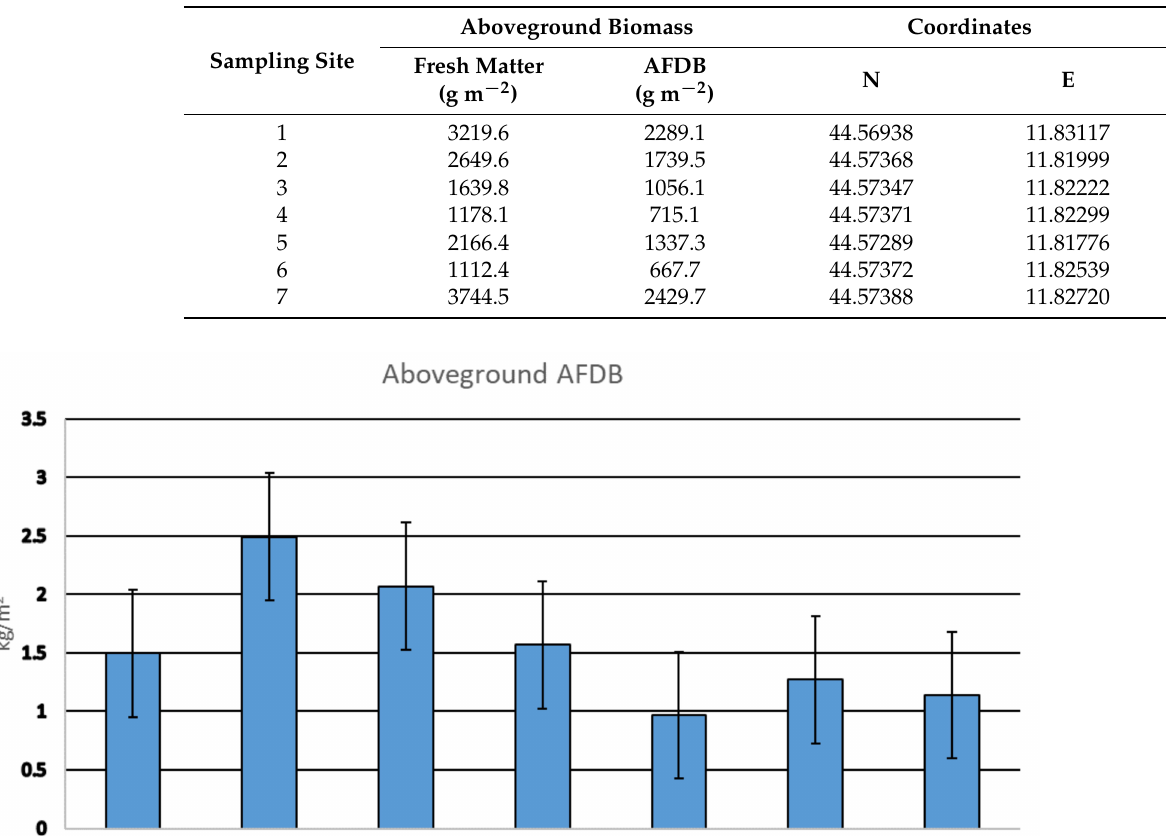
Table 3. Aboveground biomass, expressed as fresh matter and Ash Free Dry Biomass (AFDB), in the 7 sampling sites used for calibration of satellite images.